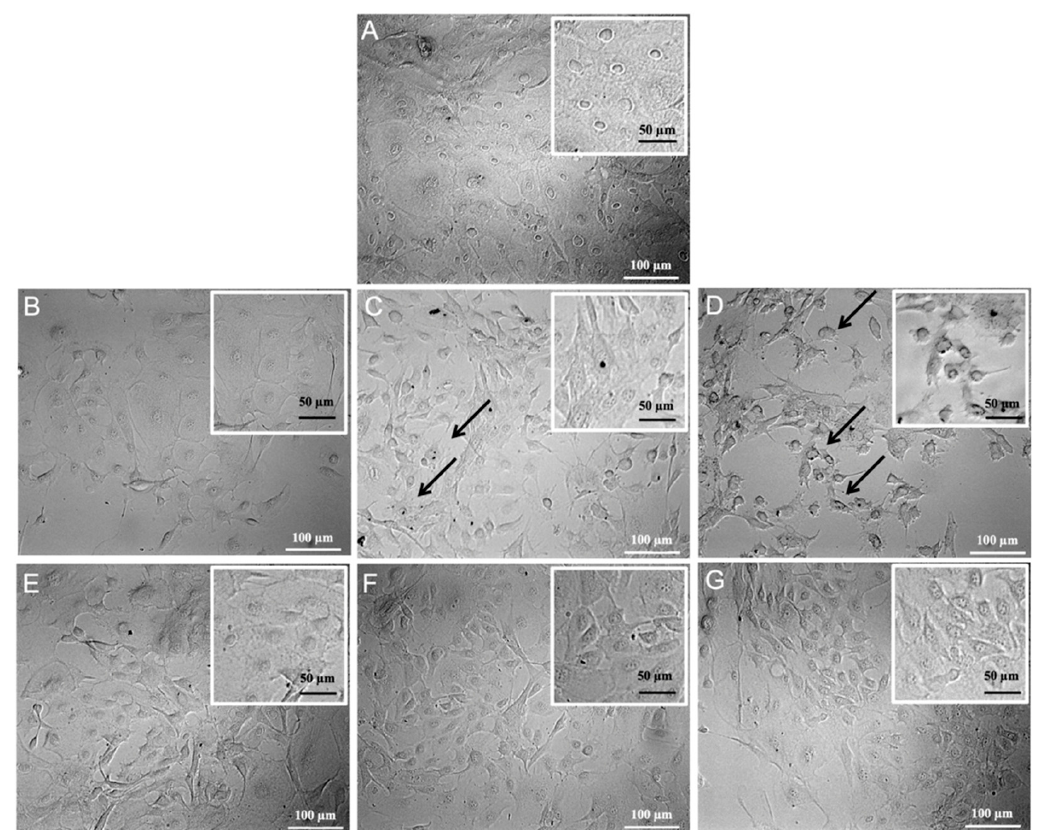
Figure 10. An example of phase contrast inverted microscope images of LA non-buffered and buffered treated oAECs. ( A ) The control cells (CTR) at 24 h were present in high density and showed a polygonal shape with regular dimension. ( B ) The cells exposed to 5 mM LA (24 h) did not differ from CTR 24 h. ( C ) The cells treated at 10 mM LA (24 h) started to show a suffering status (indicated by arrows). ( D ) The cells treated at 20 mM LA (24 h) became sparse, presenting pyknotic nuclei and blebs (indicated by arrows). ( E ) The cells exposed to 5 mM, ( F ) 10 mM, and ( G ) 20 mM buffered LA (24 h) did not differ from CTR 24 h. Scale bar of large images = 100 μ m; scale bar of inset images = 50 μ m.